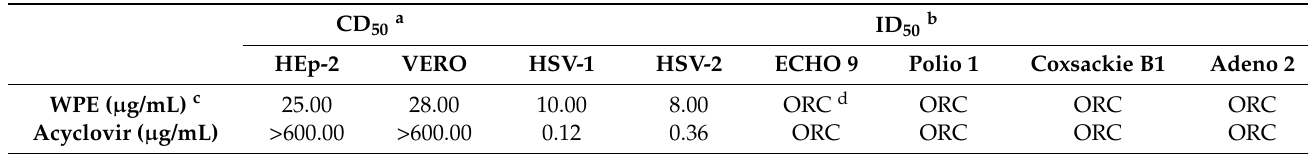
Table 1. Antiviral activity of walnut pellicle